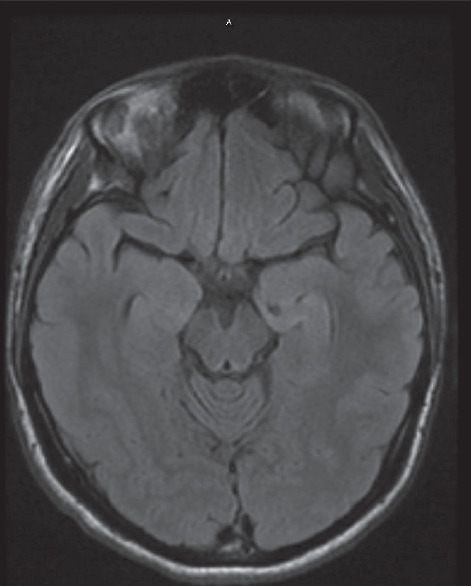
Normal brain MRI.